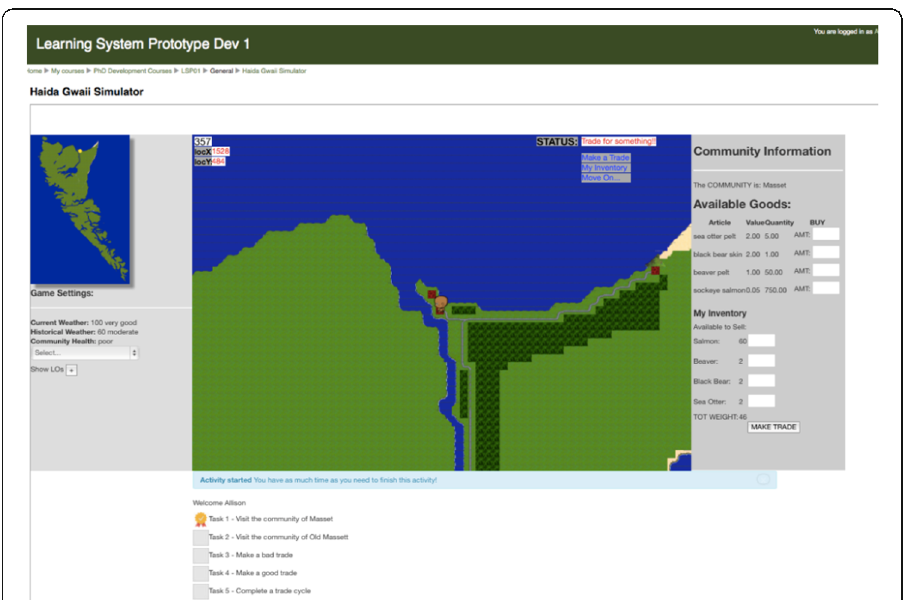
Fig. 5 Map-based learning tool based on fuzzy-logic